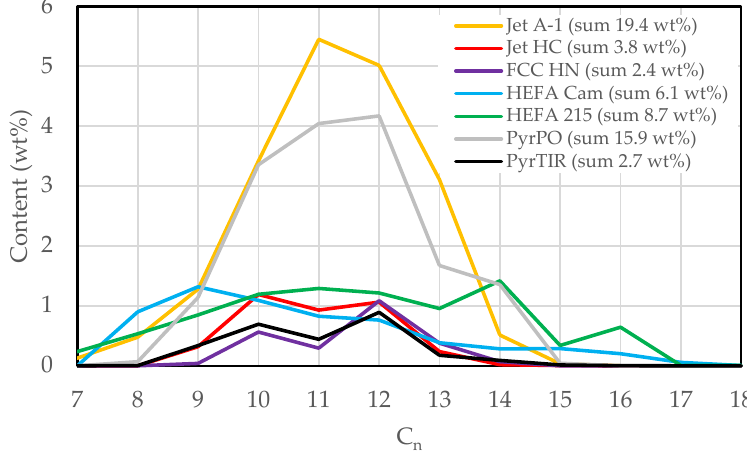
Figure 4. Distribution of n-alkanes in the samples studied by carbon number.